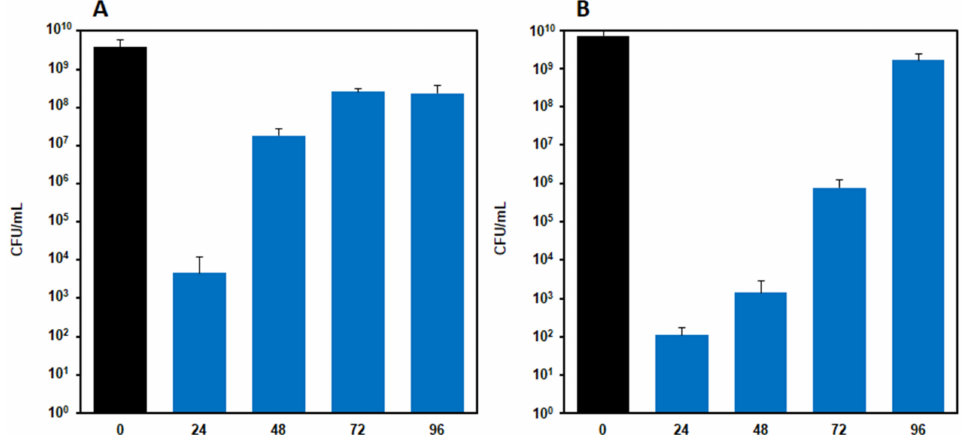
Figure 8. Antimicrobial activity of F40 nanocomposite films tested in liquid culture media on ( A ) Staphylococcus aureus ATCC 6538 and ( B ) Escherichia coli MG1655. Films were daily moved in fresh culture media containing 10 8 CFU/mL microorganisms for 4 days, and, at each time point (24, 48, 72 and 96 h), the residual bacterial concentration was measured. Results are reported as the mean ± the standard deviation ( n =